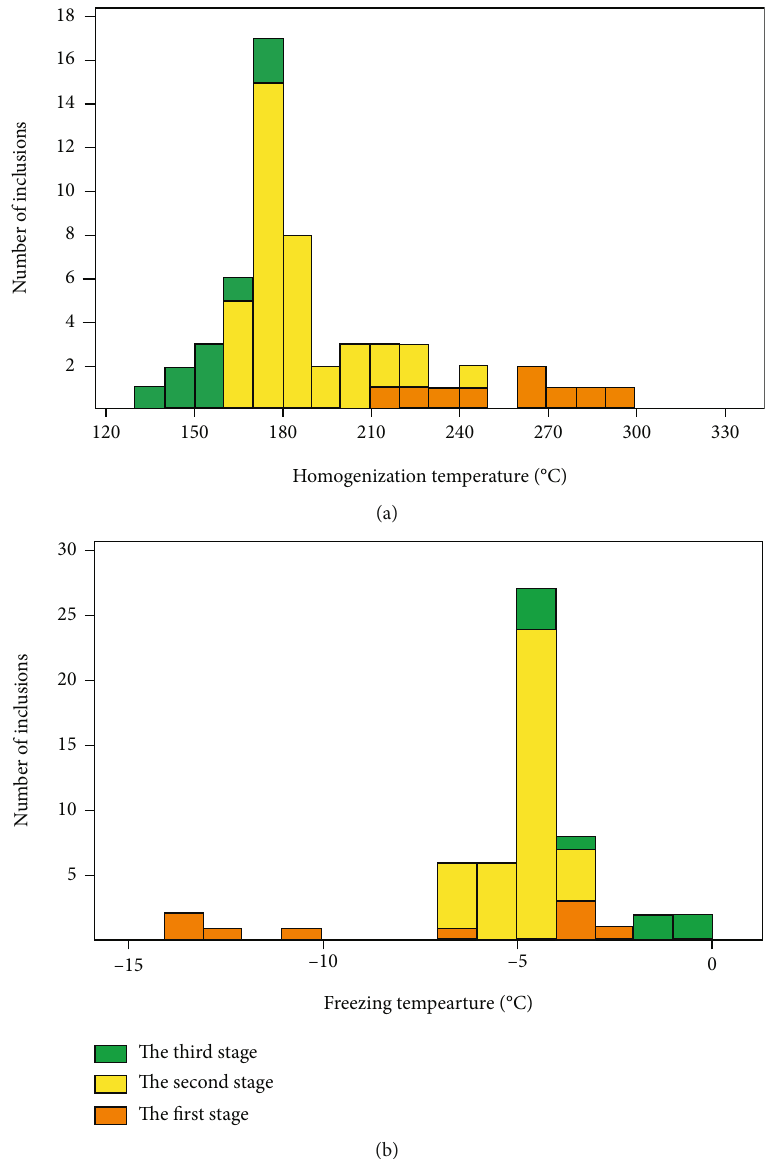
Figure 9: (a) Frequency histogram of the homogenization temperature of the Daping metallogenic fl uids. (b) Frequency histogram of the freezing temperature of metallogenic fl uids. The homogenization temperature data and freezing temperature data are from microthermometric analysis of the fl uid inclusions (this